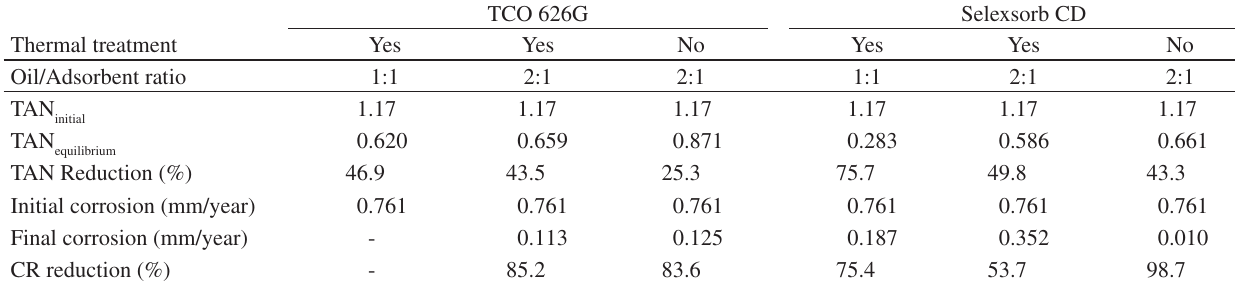
Table 4. Results of TAN and CR reduction.